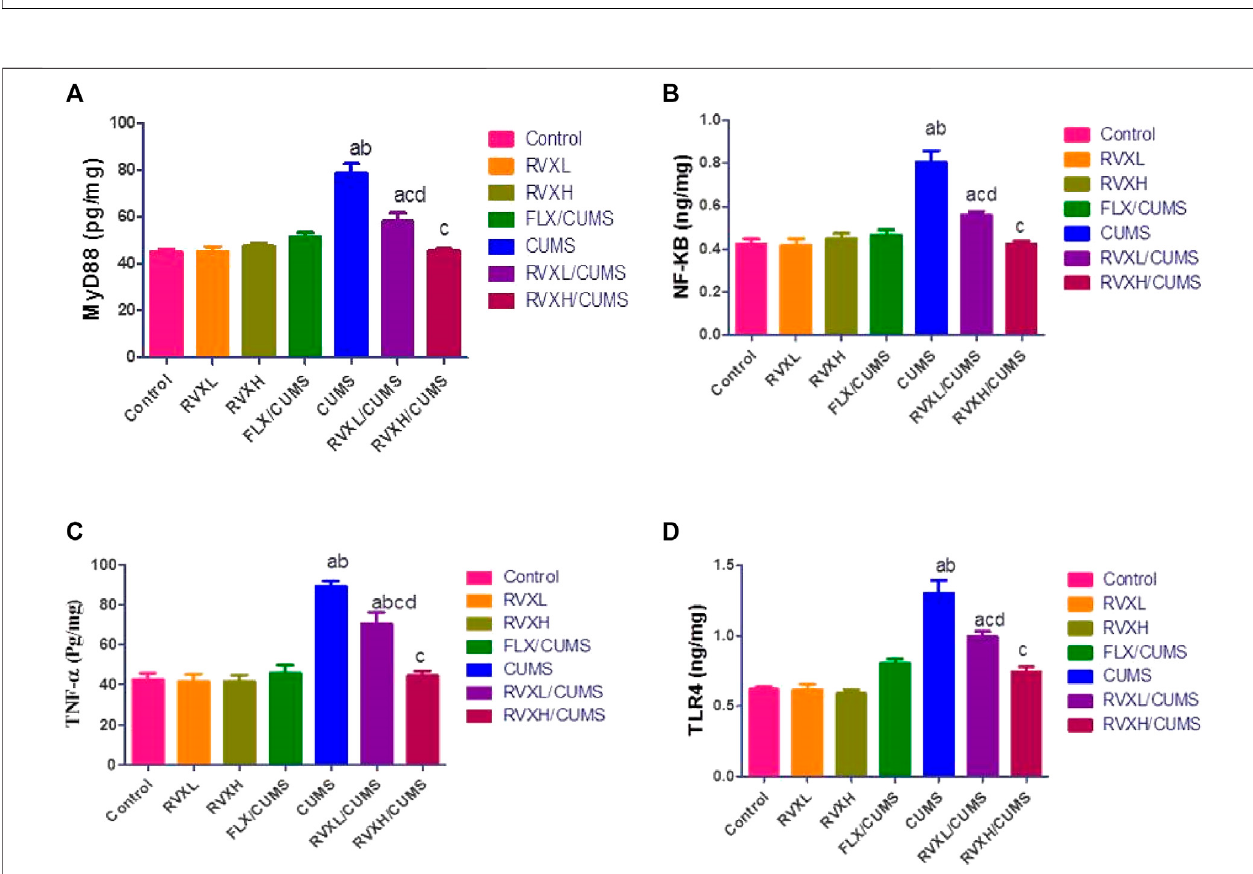
FIGURE 3 | The fi ndings are displayed as mean ± S.E.M. Signi fi cant difference at p < 0.05. a signi fi cant difference compared to the control, b signi fi cant difference compared to the FLX group, c signi fi cant difference compared to the CUMS group, and d signi fi cant difference compared to the RVXH ( p < 0.0001). CUMS, chronic unpredictable mild stress; FLX, fl uoxetine; NFkB, nuclear factor Kappa B; MyD88, myeloid differentiation factor 88; RVX L, rivaroxaban low dose; RVX H, rivaroxaban high dose; TLR4, Toll-like receptor 4; and TNF- α , tumor necrosis factor- α